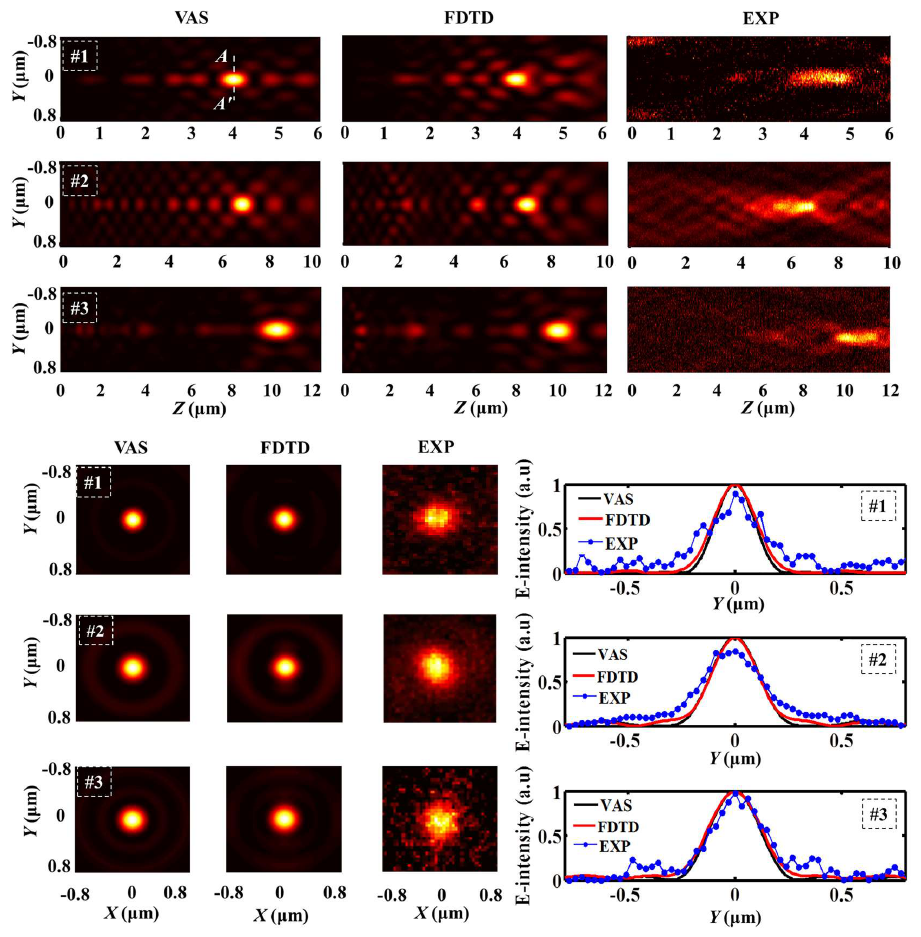
Figure 5. Top: electric intensity distributions in Y - Z planes of the three samples through VAS, FDTD simulation, and experiment. Bottom: Intensity profiles in the focal planes of the three samples obtained from VAS, FDTD simulation, and experiment. Besides, the corresponding normalized intensity distributions in the focal planes of the three samples are also shown.